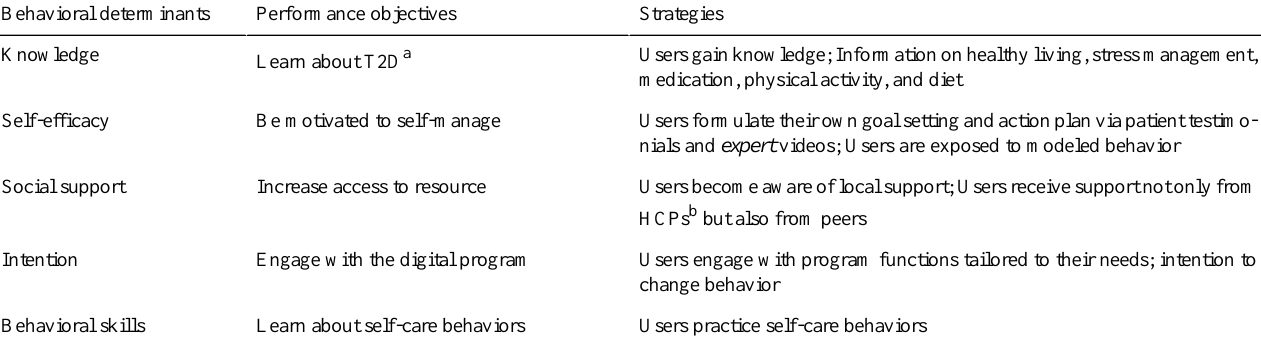
Table 1. Matrix of